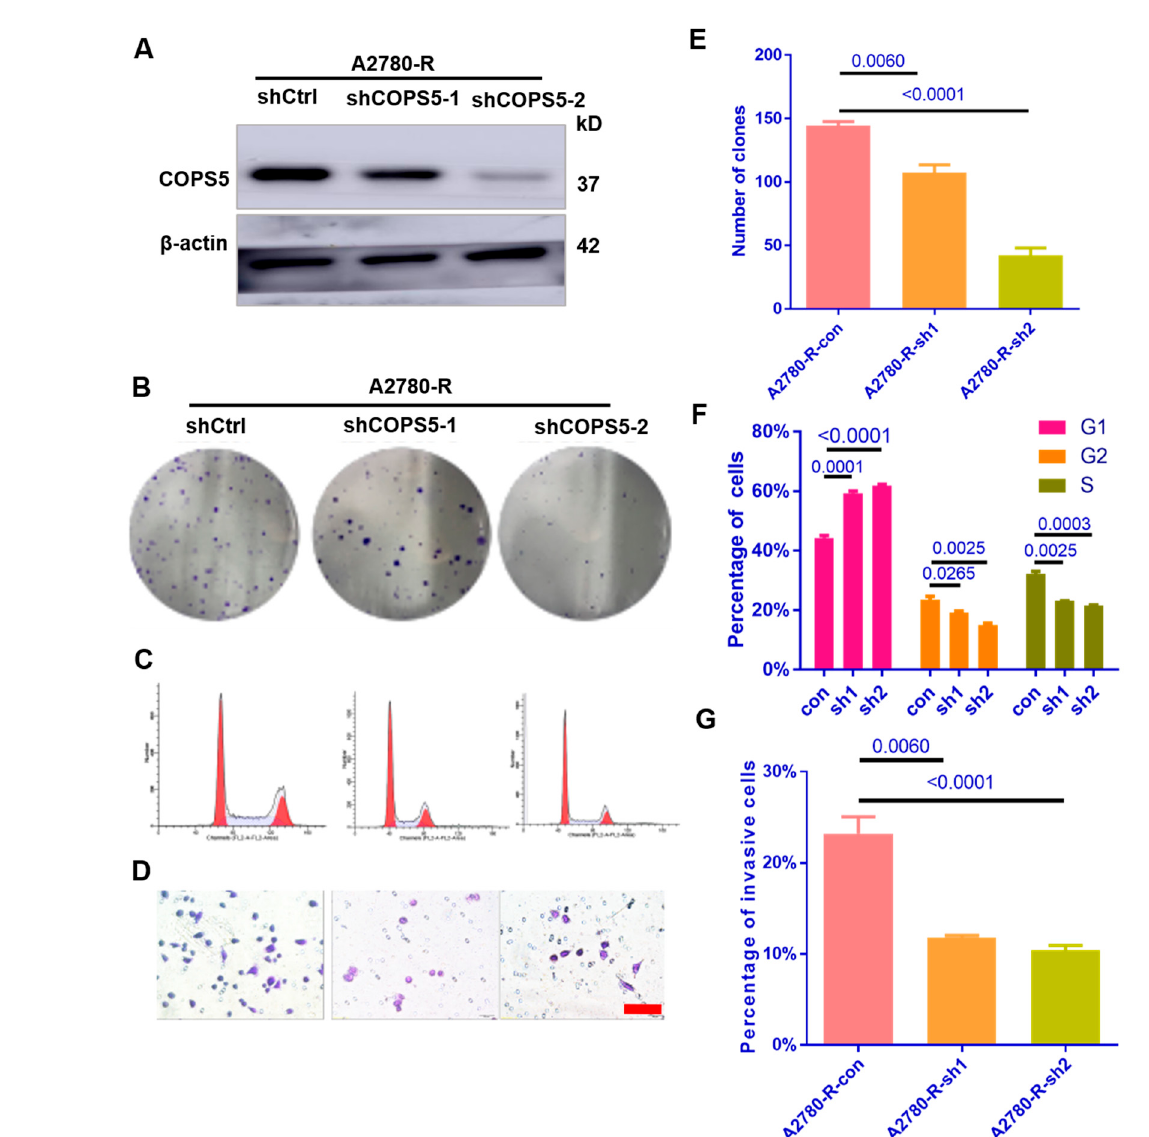
Figure 3. Down-regulation of COPS5 diminished the speed of cell proliferation and migration. Validation of the COPS5 knockdown efficiency ( A ). Effects of COPS5 silencing on the colony formation ability ( B , E ). Knockdown of COPS5 in platinum-resistant A2780 cells led to cell-cycle arrest ( C ). The bar graph shows the percentages of each cell cycle phase( F ). Images of the Transwell assay (400 × ) and quantification of the Transwell assay ( D , G